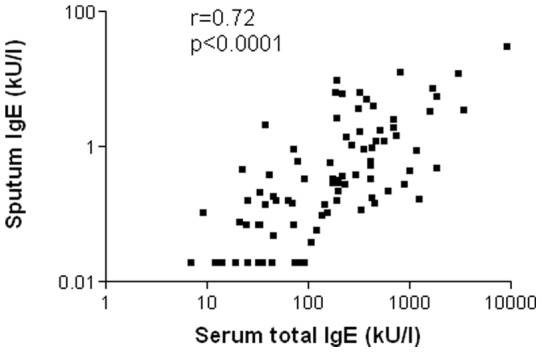
Correlation between sputum total IgE and serum total IgE in asthmatics.